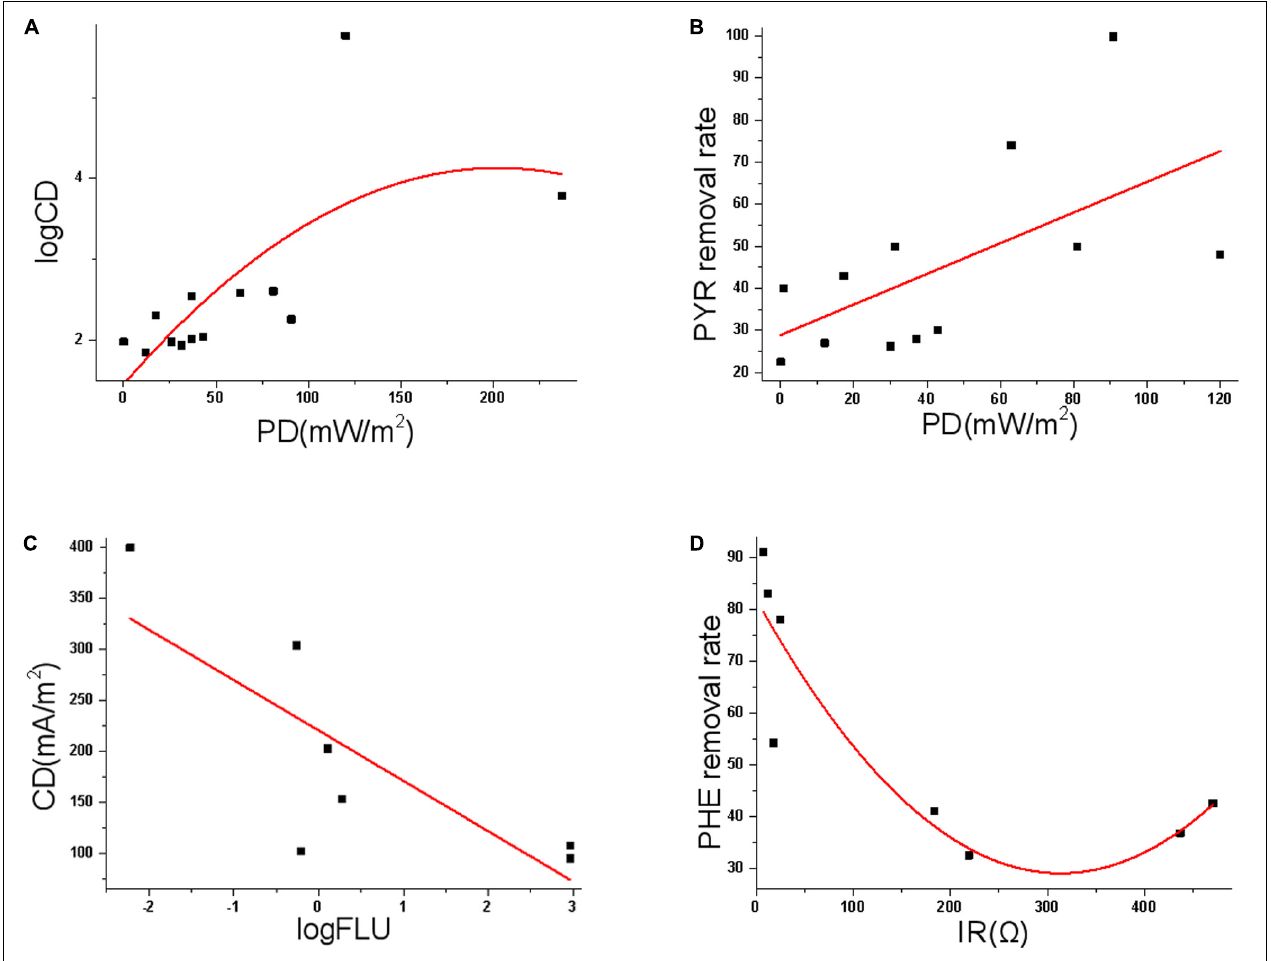
FIGURE 5 | (A) Polynomial fit of the correlation between PD and logCD; (B) linear fit of the correlation between PD and PYR removal rate; (C) linear fit of the correlation between log(FLU start concentration) and CD; (D) polynomial fit of the correlation between IR and PHE removal rate.